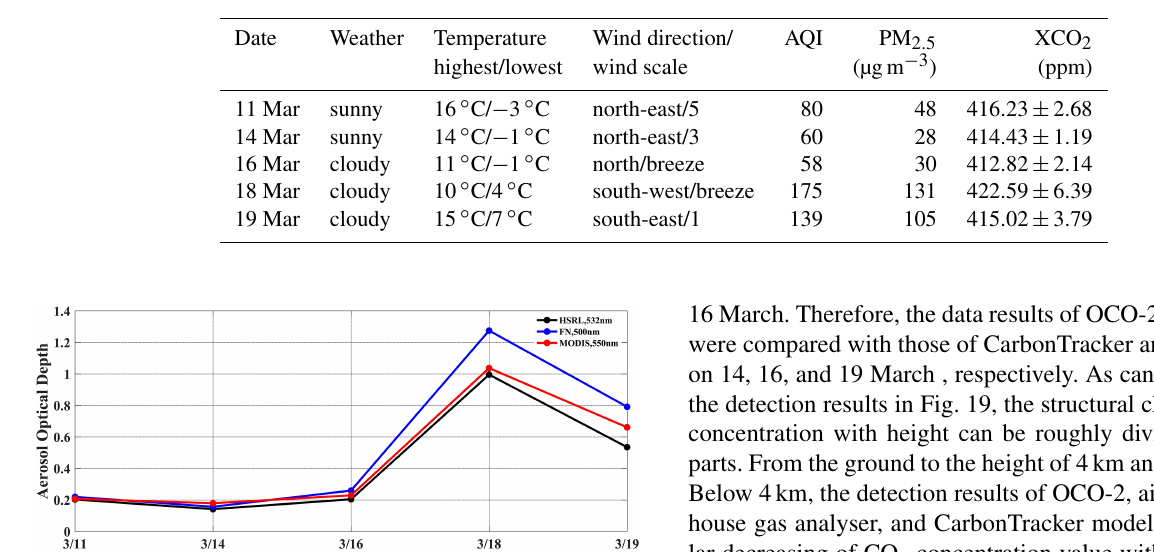
Table 3. The weather report released by the Qinhuangdao Meteorological Bureau on each flight day.